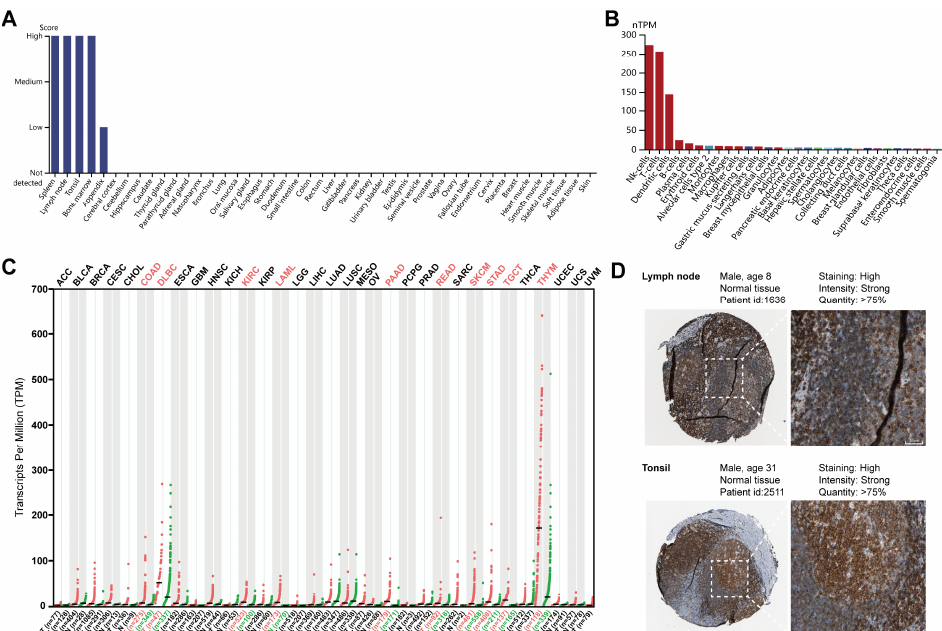
Figure 2. LCK expression profile across normal tissues and tumor samples. ( A ) Relative expression level of LCK in human normal tissues. ( B ) LCK expression was calculated using the consensus normalized expression (nTPM) value in different normal cell types. ( C ) Expression of LCK in 33 tumor tissues and their adjacent normal tissues. ( D ) Immunohistochemical staining of LCK in human lymph node and tonsil.